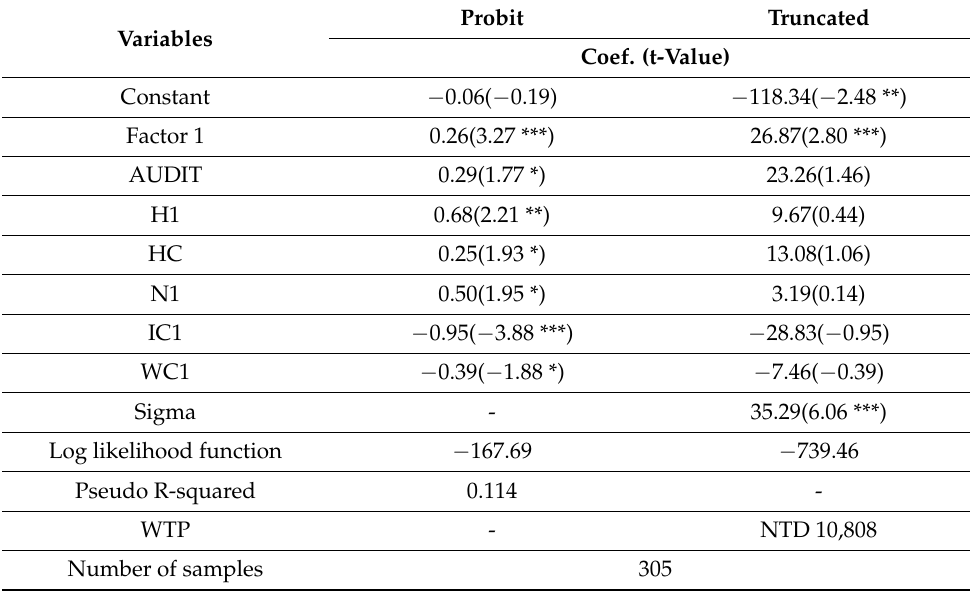
Table 10. Double-hurdle model calibration table for drunk are